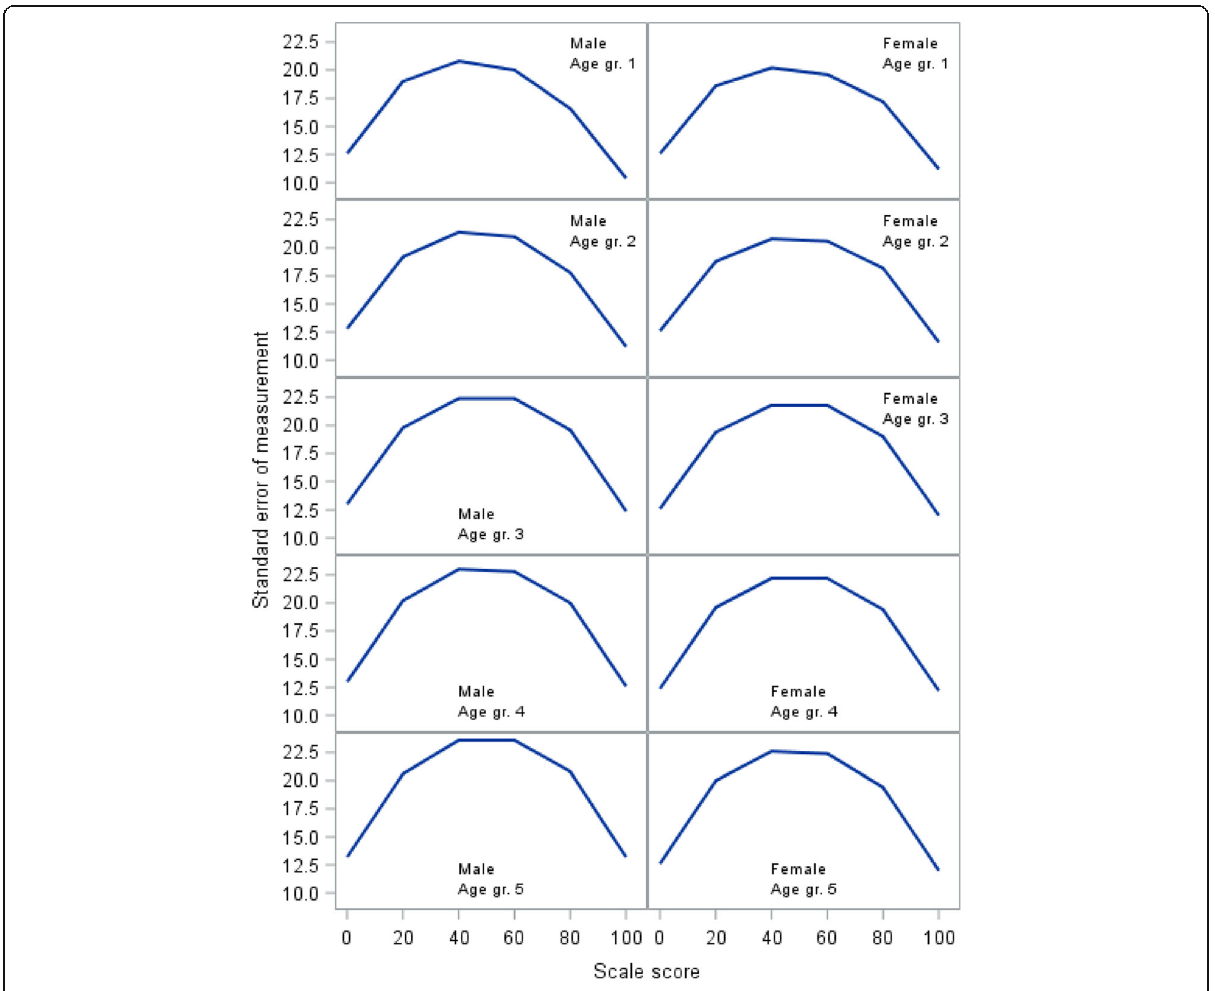
Fig. 3 Standard error of measurement for the Lifestyle